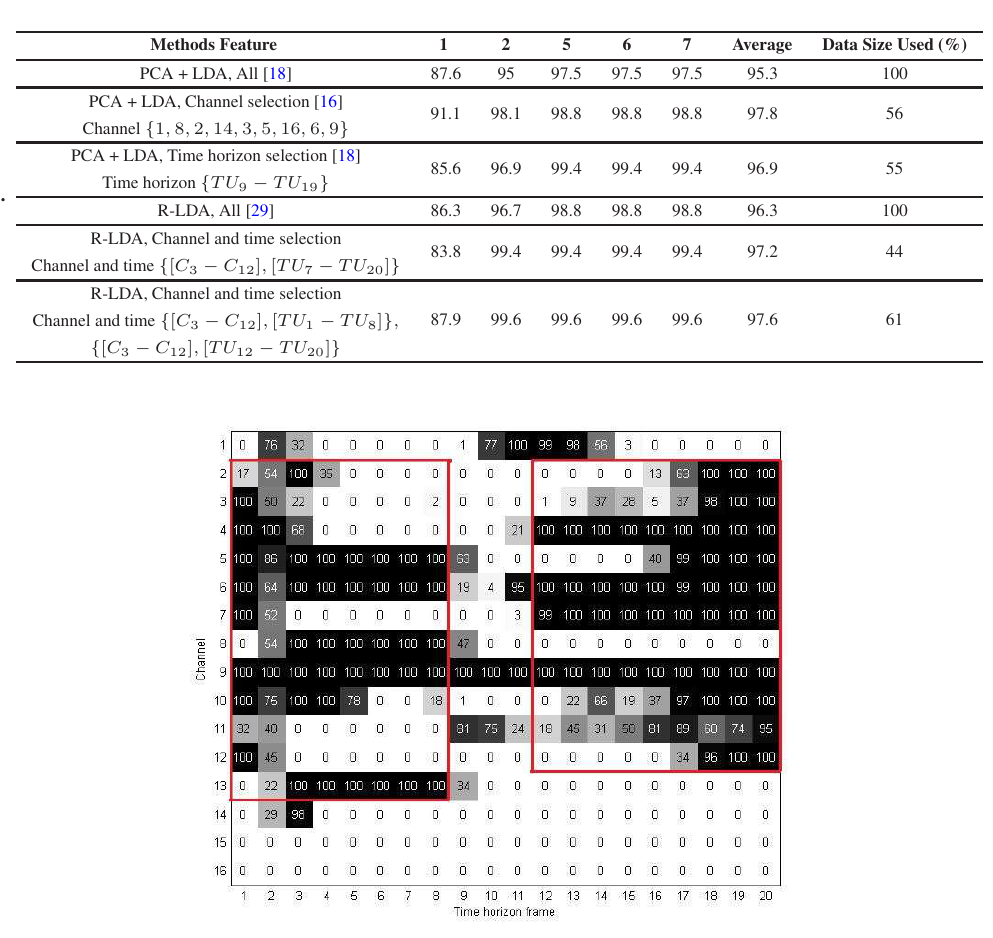
Table 3. Average classification rates of different selection methods (%).